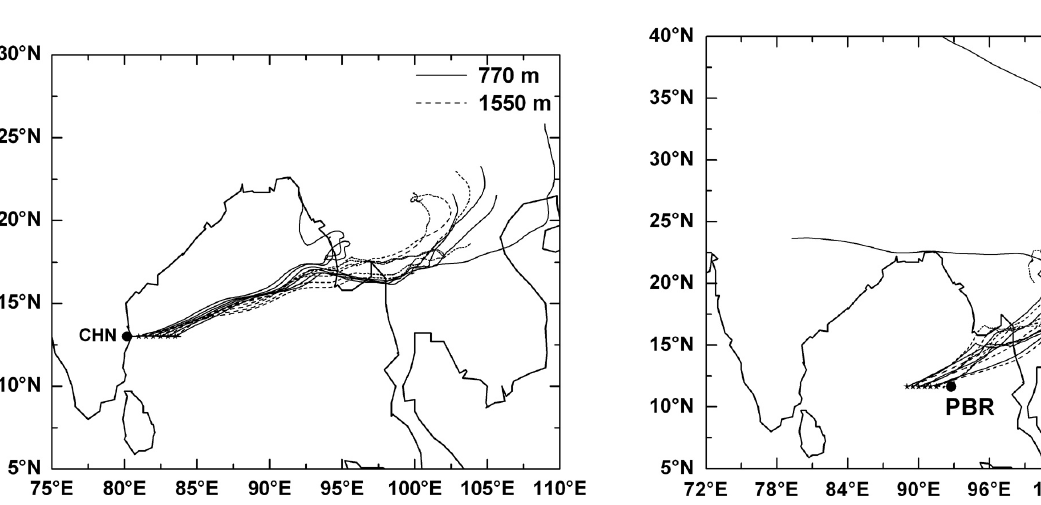
Fig. 8. Longitudinal variation of σ tsc at 770 (upper panel) and 1550m (lower panel) altitude off-CHN during BL6 over 13 ◦ N lati- tude. Solid line represents best linear fit showing increasing trend in σ tsc values off-CHN into central BoB. The arrows in both the panels represent the longitude of CHN airport.